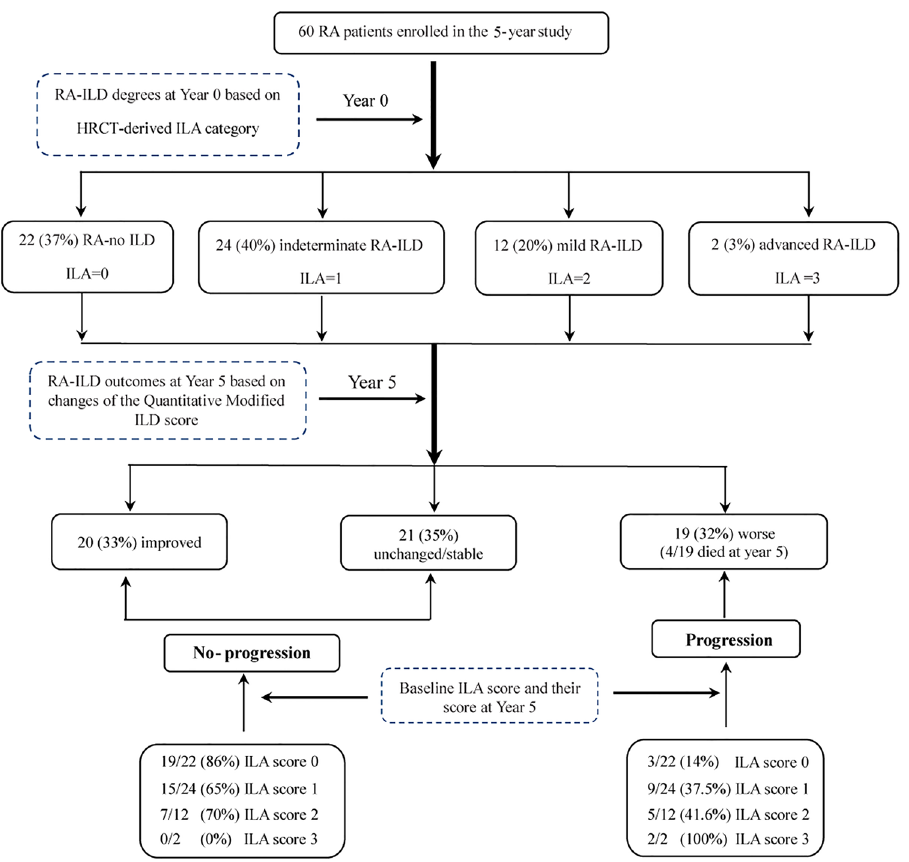
Figure 1. Study enrollment at Year 0 and Year 5. A flow diagram of the study shows the different degrees of RA-ILD based on 0–3 ILA scores in HRCT at Year 0 and outcome at Year 5 based on changes of Quantitative Modified ILD scores. Changes in the Quantitative Modified ILD score between 0–10% at Year 0 and Year 5 were classified as stable, while reduction of ILD scores by greater than 10% was classified as better (score reduction > 10%) and changes more than 10% increased as worse. HRCT = high-resolution computed tomography; ILD = interstitial lung disease; ILA = interstitial lung abnormality; RA = rheumatoid